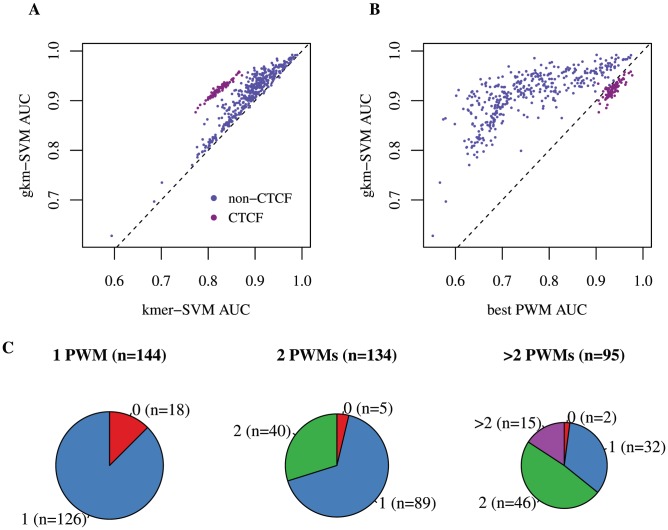
gkm-SVM consistently outperforms kmer-SVM and the best known PWM on human ENCODE ChIP-seq data sets.(A) We trained gkm-SVM and kmer-SVM on the complete set of 467 ENCODE ChIP-seq data sets (with k = 6 for kmer-SVM, and l = 10 and k = 6 for gkm-SVM). gkm-SVM AUC is consistently higher than kmer-SVM with only a few very minor exceptions. The gkm-SVM method specially outperforms the kmer-SVM for the data sets bound by members of the CTCF complex, highlighted as purple circles. (B) We also compared gkm-SVM and the best known PWM on the same data sets, and gkm-SVM AUCs are significantly higher than the PWM AUC in almost all cases. (C) The ENCODE data sets were divided into four groups: (1) no PWM, (2) only one PWM, (3) two PWMs, and (4) three or more PWMs identified by Wang et al. Then, for each group except the first one, we calculated the number of PWMs recovered by our method. At least one PWM was recovered for more than ∼90% of the data sets.